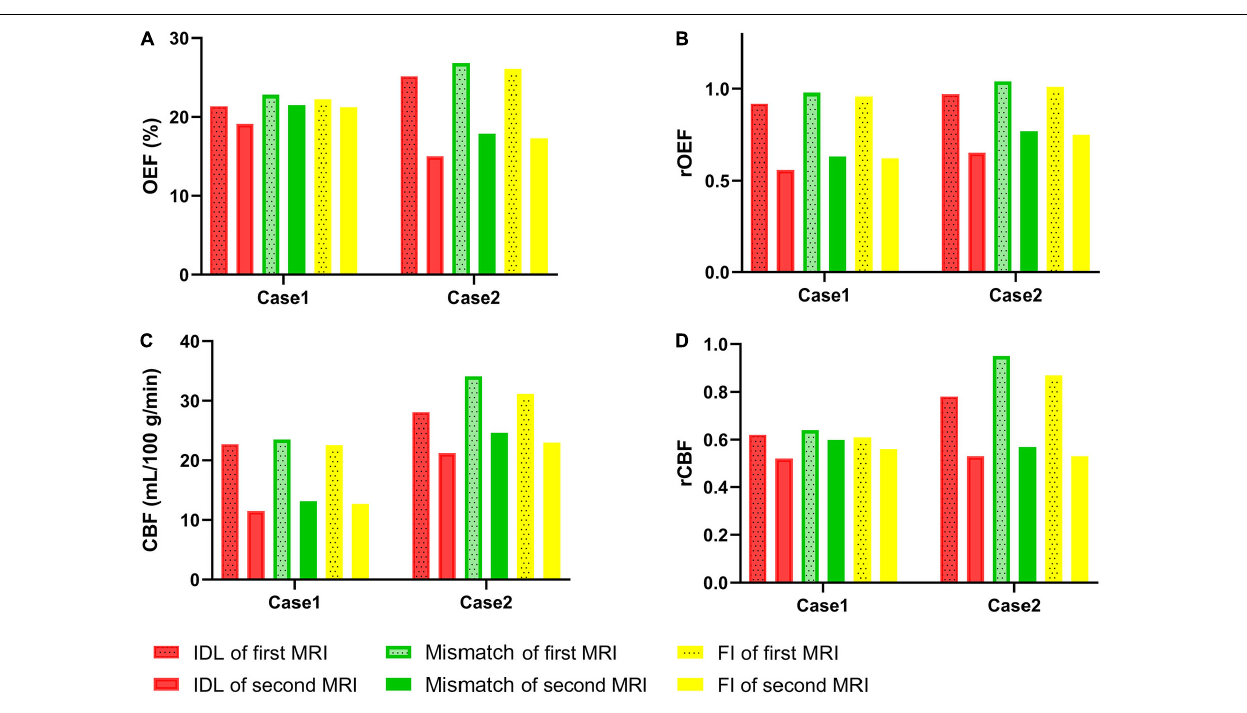
reperfusion or recanalization of the ischemic tissue with or without endovascular therapies (Albach et al., 2013; Asdaghi et al., 2014) and absent or less severe perfusion deficit within